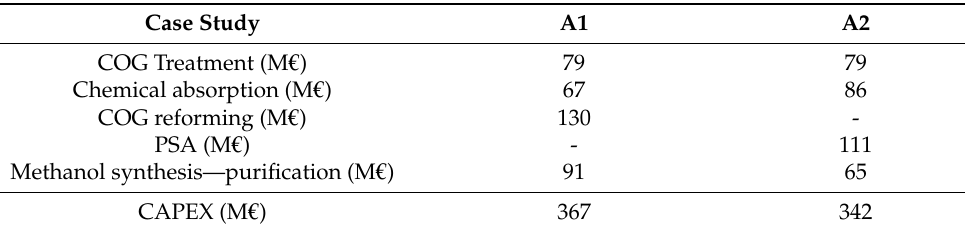
Table 7. Contributions to CAPEX for case studies A1 and A2 (surrounding factor of 1.8).